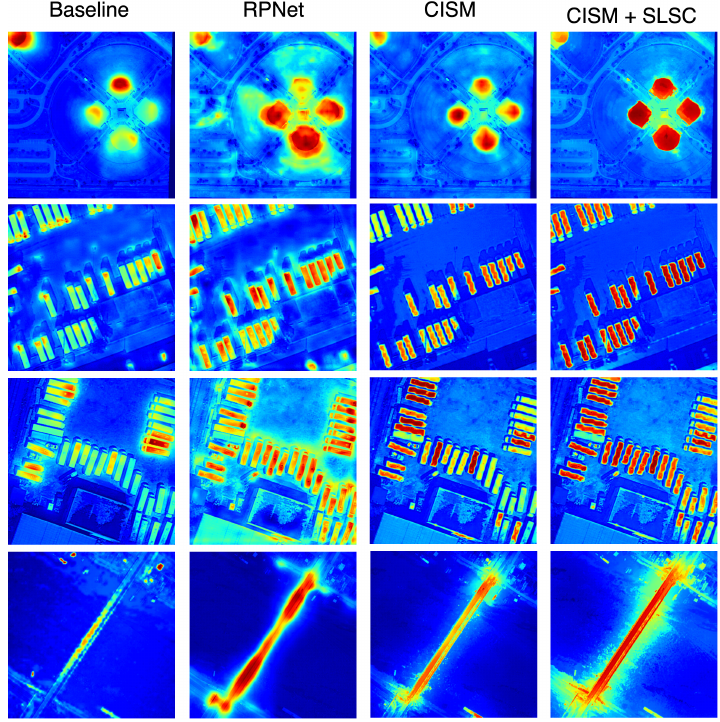
Figure 9. The visualization after adding the SLSC.